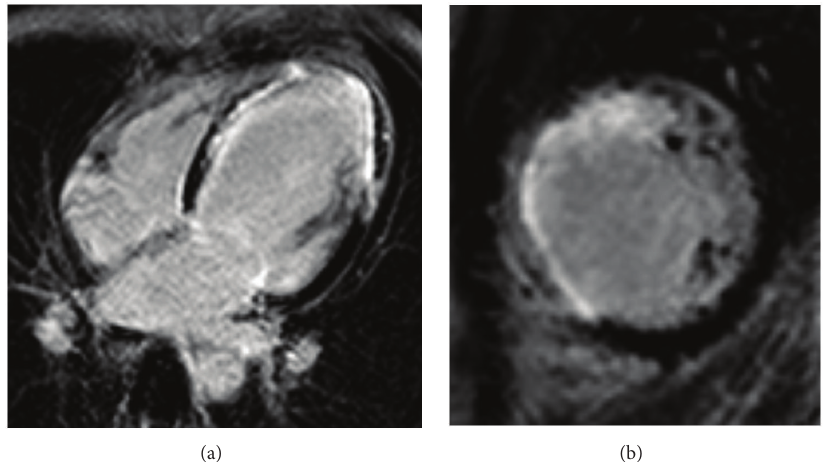
Figure 4: Cardiac MRI. (a) Four-chamber view, obtained 15 minutes after intravenous gadolinium injection. The anterolateral segment shows delayed enhancement in less than 50% of the myocardial thickness. (b) Short-axis view, obtained 15 minutes after intravenous gadolinium injection, showing transmural delayed enhancement of the midcavitary septal